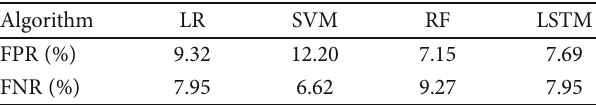
Table 3: The FPR and FNR in the periods of declining sensor glucose without a hypoglycemic event when the metric of MSG+gradient was adopted at the prediction horizon of 30